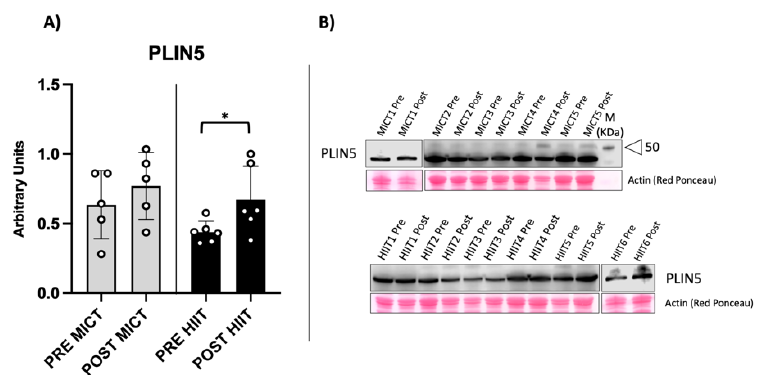
Figure 5. Perilipin 5 protein content. PLIN5 is a protein involved in LDs formation, as well as in establishing contacts with mitochondria. ( A ) Histogram showing significant increase in PLIN5 expression in HIIT group. ( B ) Example of the immunoblot and marker of molecular weight. Western blot results are derived from two separate blots as shown in the figure. * = p ‐ value < 0.05 ( p = 0.049 in HIIT).